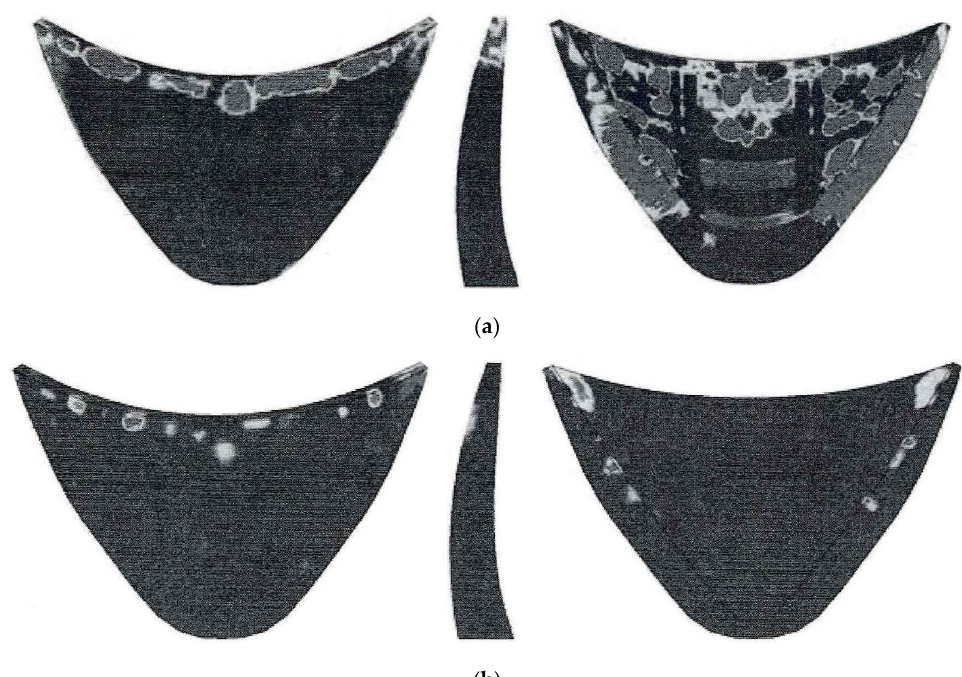
Figure 27. Arch dam damage cloud chart with 10 m underwater initiation. ( a ) Upstream surface, arch crown cantilever, and downstream surface view damage cloud chart without a foamed aluminum protective layer. ( b ) Upstream surface, arch crown cantilever, and downstream surface view damage cloud chart with a foamed aluminum protective layer.